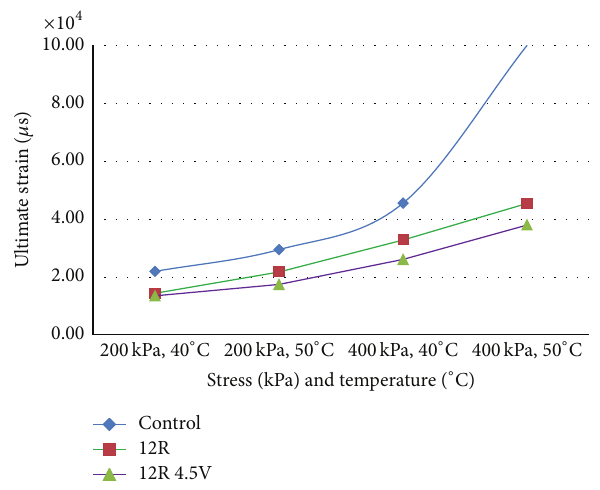
Figure 4: Ultimate strains for control and rubberized mixtures at different stress level and temperature.